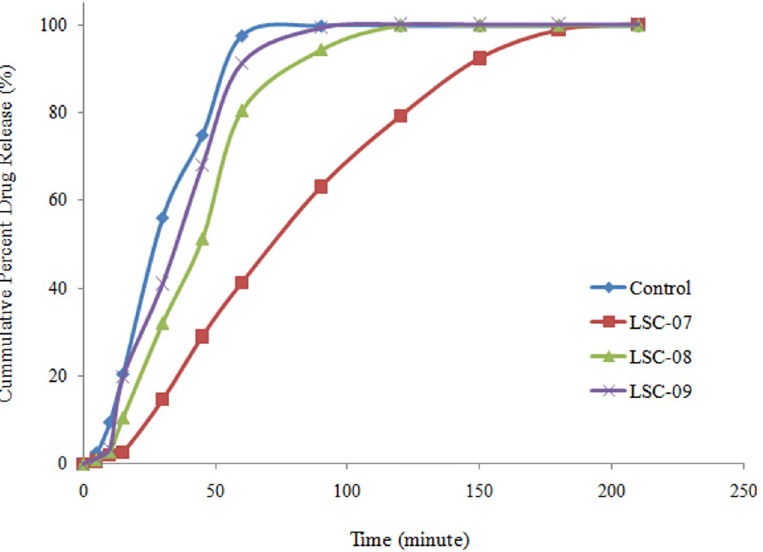
Fig 7. Drug release from liquisolid compacts containing different concentrations of